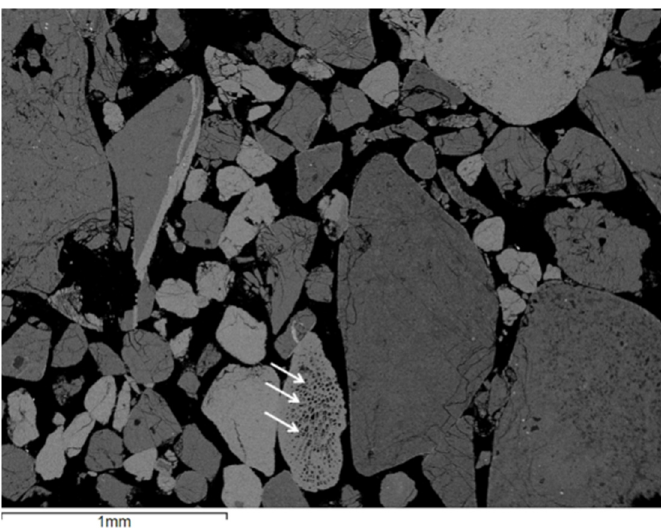
Figure 12. BSE-SEM image indicating evidences of carbonate material dissolution by microorganisms (see arrows) in L1 sample.